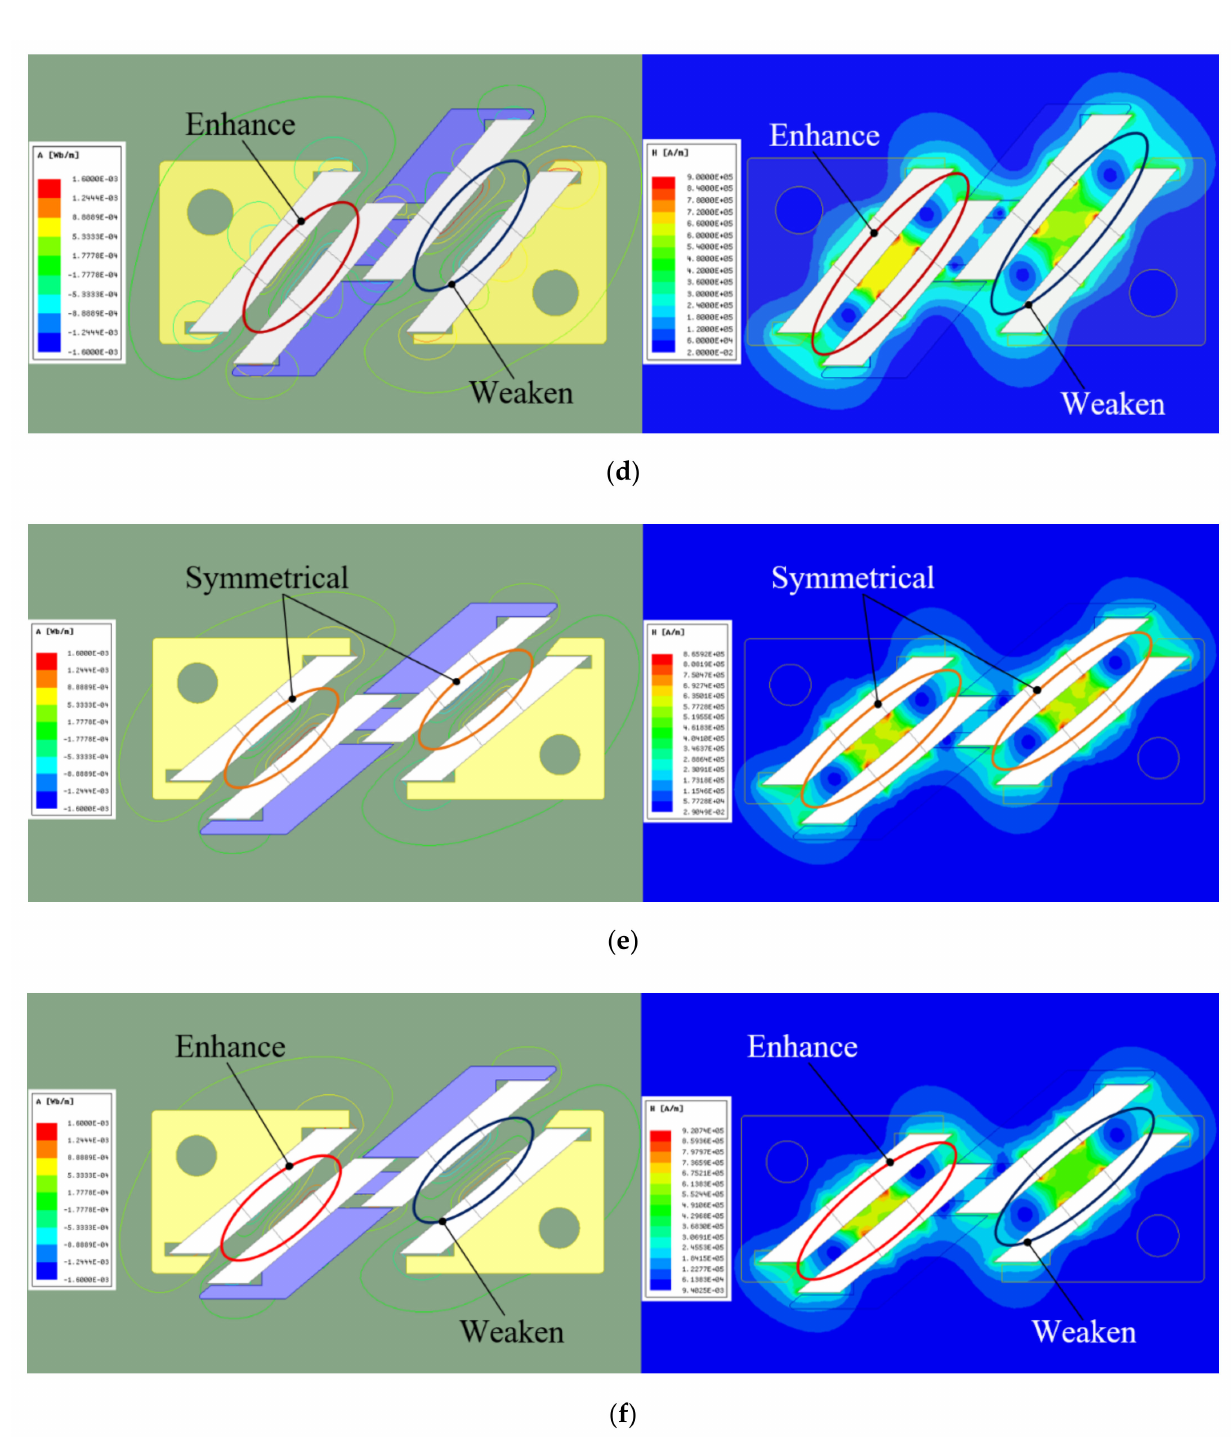
Figure 13. Magnetic flux line diagram and contour plot of maglev coupling: ( a ) α = 30 ◦ , c 0 = 1.22 mm, ∆ w = 0 mm; ( b ) α = 30 ◦ , c 0 = 1.22 mm, ∆ w = 1 mm; ( c ) α = 40 ◦ , c 0 = 0.35 mm, ∆ w = 0 mm; ( d ) α = 40 ◦ , c 0 = 0.35 mm, ∆ w = 1 mm; ( e ) α =50 ◦ , c 0 = − 0.49 mm, ∆ w = 0 mm; and ( f ) α = 50 ◦ , c 0 = − 0.49 mm, ∆ w = 1